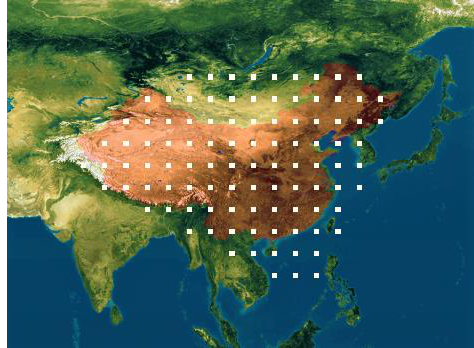
Figure 10. Area target observation